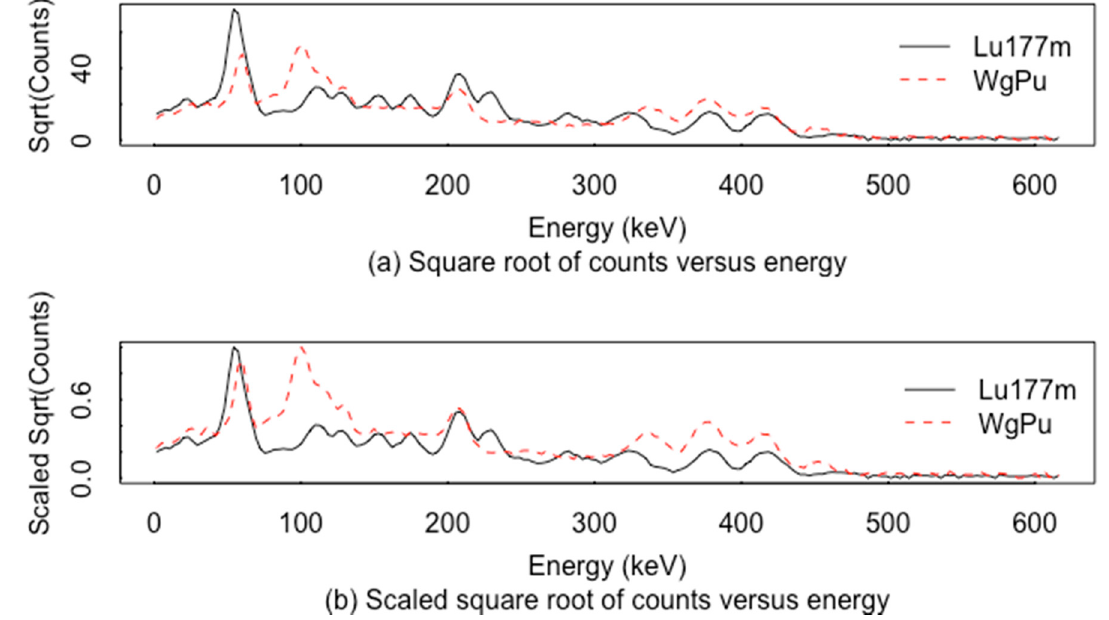
Figure 9. Simulated (smoothed) Lu177m and WgPu spectra in ( a ) and scaled to range from 0 to 1 in ( b ).